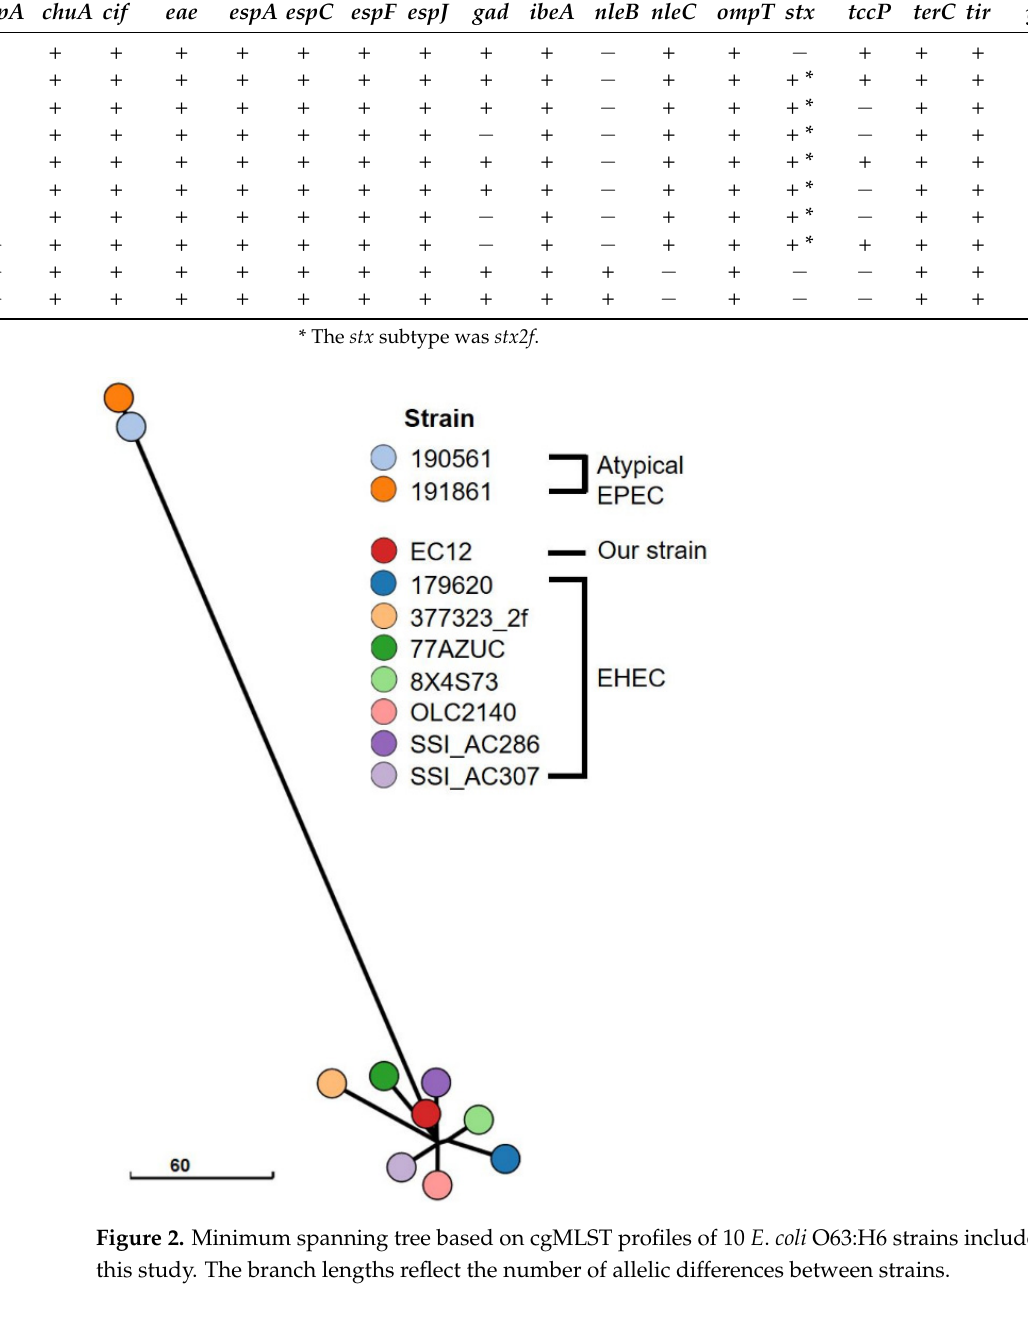
Figure 3. Genome comparison of strains EC12 and 377323_2f. ( A , B ) Chromosome comparisons using Mauve ( A ) and BRIG ( B ) demonstrate a gap of around 42.5 kbp in EC12 corresponding to the stx -harboring prophage sequence. ( C ) Plasmid alignment using Mauve shows that pEC12_1 contains the whole sequence of p377323_2f. In Mauve, identically colored boxes represent homologous regions shared by the aligned genomes. 4. Discussion So far, stx2f has been the only stx subtype found in E . coli O63:H6 strains [3–6]. STEC strains carrying stx2f are generally associated with mild disease, potentially because these strains carry a relatively small number of virulence genes [5]. However, stx2f -positive STEC strains can cause severe disease such as HUS, albeit rarely [6,21]. Although stx2f - positive STEC strains are frequently found in pigeons, STEC serotypes associated with